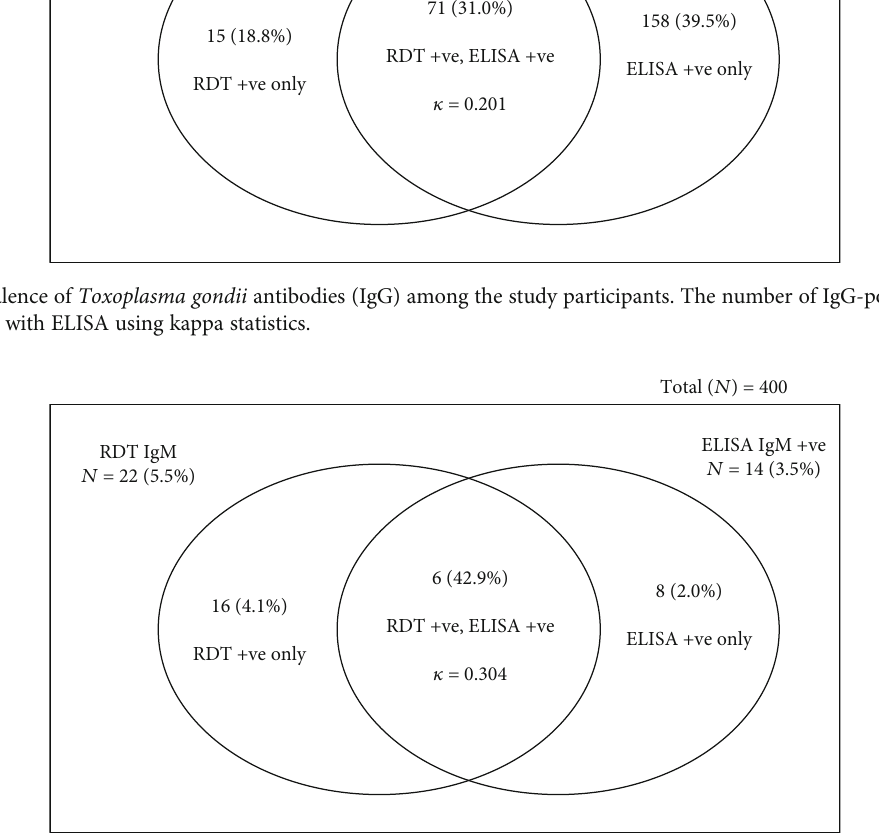
Figure 3: Seroprevalence of Toxoplasma gondii antibodies (IgM) among the study participants. The number of IgM-positive cases based on RDT was compared with ELISA using kappa